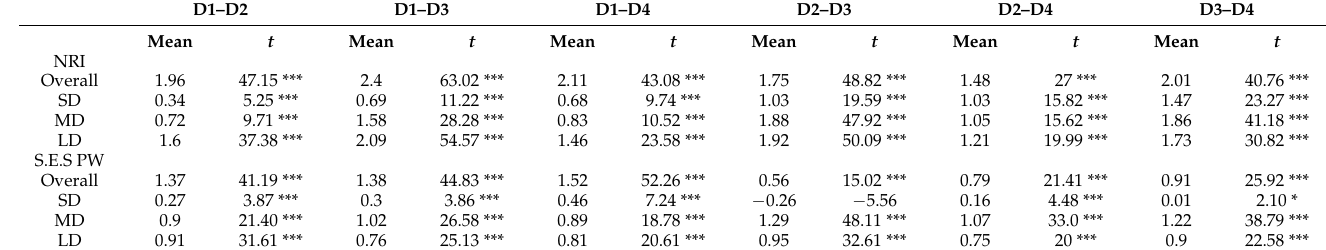
Table 5. Results of t -tests of the hypothesis that the mean value of NRI or S.E.S PW is zero in pairs of different disturbance communities. D1, D2, D3, and D4 represent the plantation, twice-cut, once-cut, and old-growth forests, respectively. “*” and “***” represent p < 0.05 and p < 0.001, respectively.